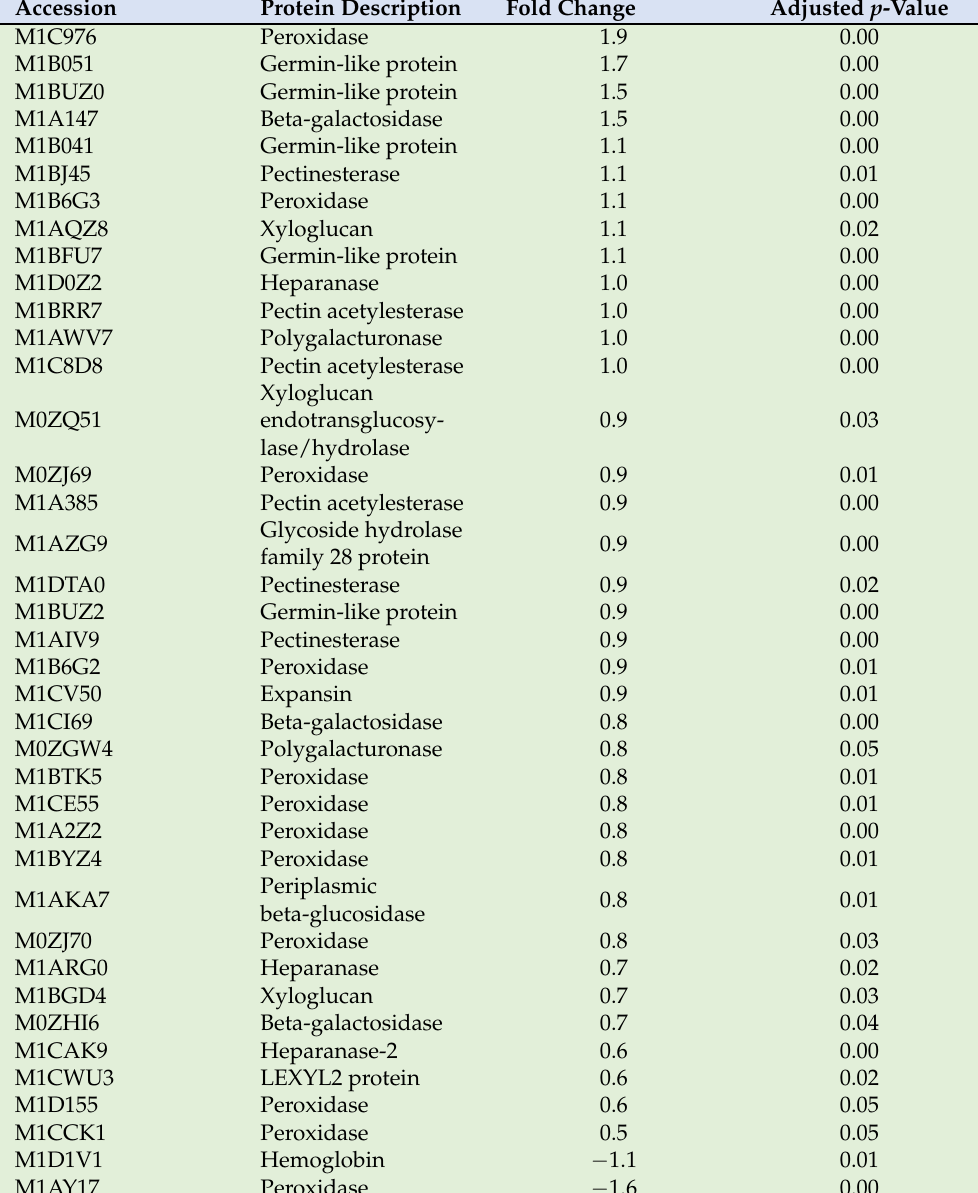
Table 1. Differentially abundant proteins in cell wall. The fold change is on a log 2 scale. Positive fold changes indicate increased abundance in resistant cultivars; negative fold changes indicate reduced abundance in resistant